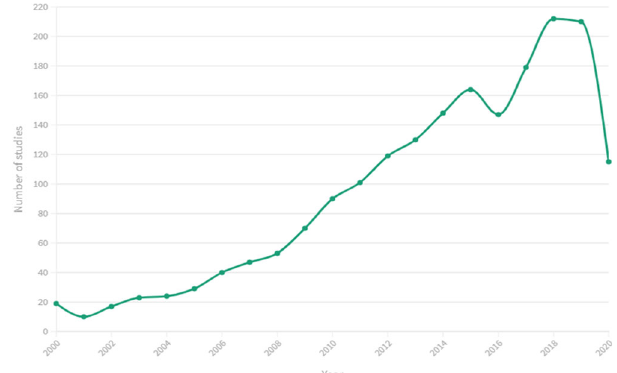
Fig. 8 | Trends over time of analytical studies linking food security and nutri- tion to mental health. The plotted line shows the increase in studies from